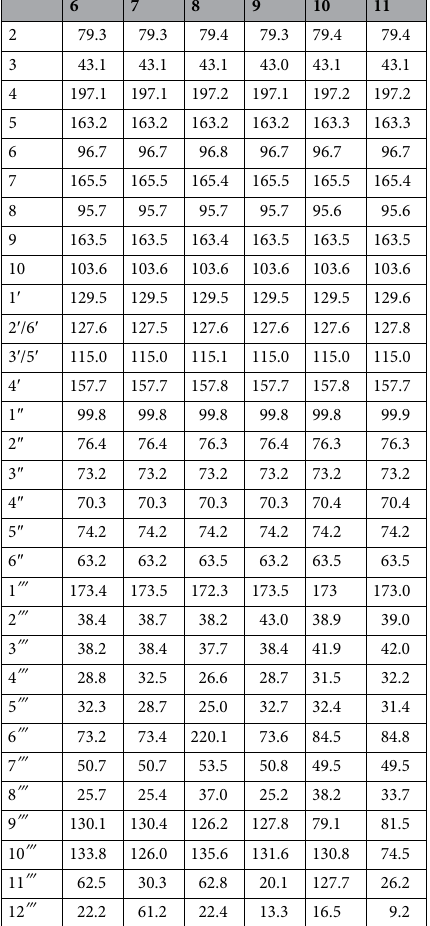
Table 3. 13 C NMR spectroscopic data for compounds 6–11 (CD 3